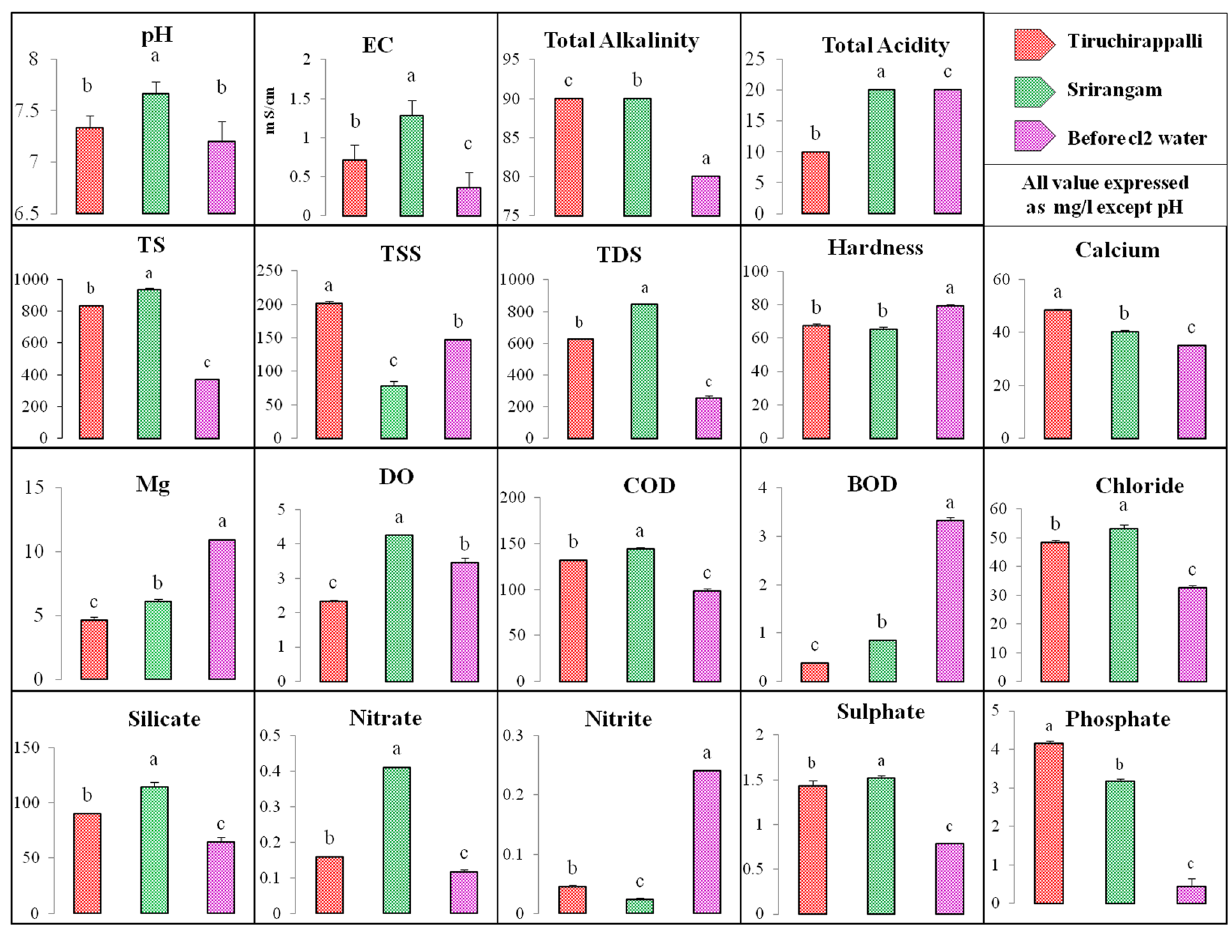
Fig. 2 Physicochemical characterization of drinking water sam- ples. Values were expressed as mean ± SD ( N = 3). Bar with differ- ent alphabets is significantly different from each other and with same alphabets has insignificant changes ( P < 0.05). The physicochemical parameters (pH, EC, alkalinity, hardness, calcium, magnesium, TS, TDS, TSS, DO, BOD, COD, phosphate, sulfate, chloride, nitrite, sili-